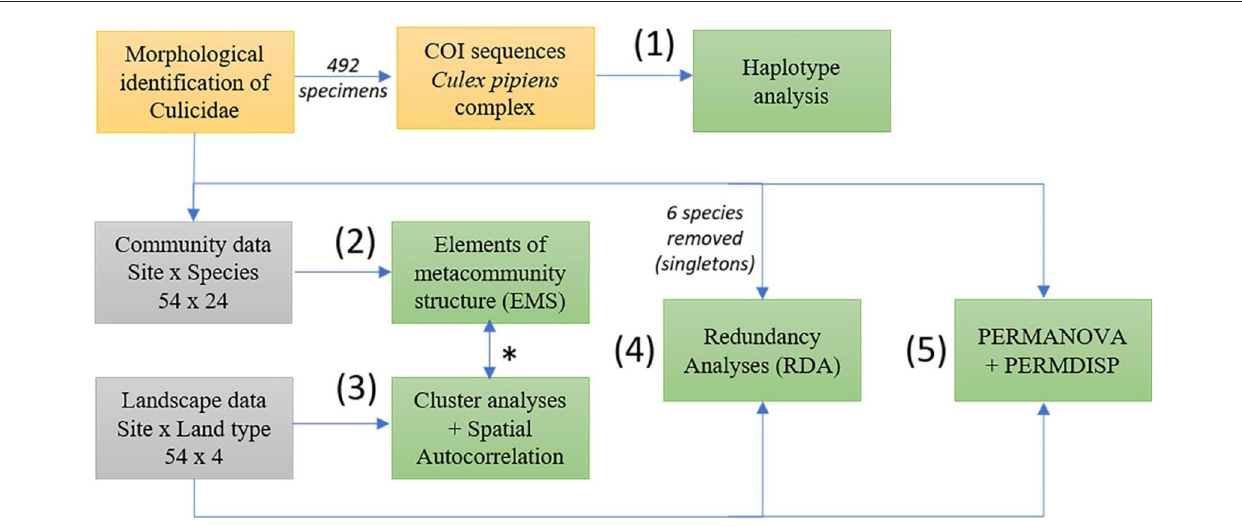
FIGURE 1 | Scheme of the statistical analyses (boxes in green) used in this study. Mosquito and landscape data were collected in 54 sampling sites in south-eastern Illinois in 2016 and 2017. Individuals of Culicidae were identified using morphological characters and a subsample of 492 specimens belonging to Culex pipiens complex were further analyzed molecularly (boxes in yellow box), haplotype network analysis was applied to evaluate their genetic distance (1). Community data (box in gray) were used to identify metacommunity properties emerging from the observed structure (2). Landscape data (box in gray) informed cluster analyses, verify spatial autocorrelation of sites (3) and the correlation with sampling site scores from community data (*). Redundancy analysis with forward selection was performed to select the most important environmental variables that explain variation in the community matrices (4). PERMANOVA and PERMDISP were used to compare the variance and homogeneity of environmental and community distances between communities collected in different landscape units